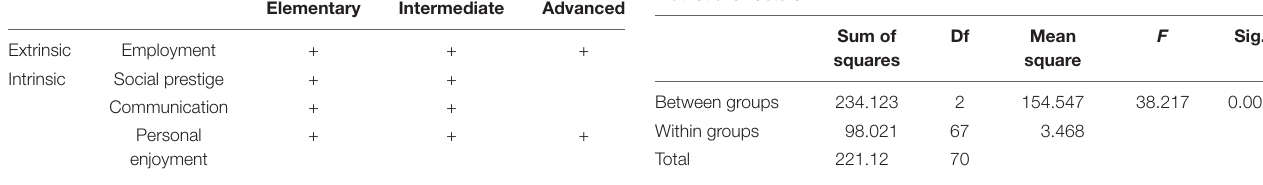
TABLE 10 | ANOVA analysis for comparing mean scores in respondents’ motivational